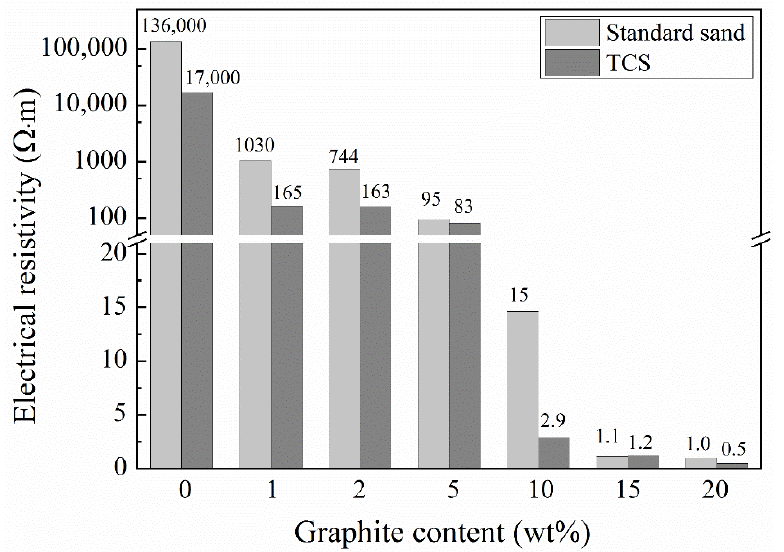
Figure 5. Effect of graphite content on the electrical resistivity of dried cement mortars with different